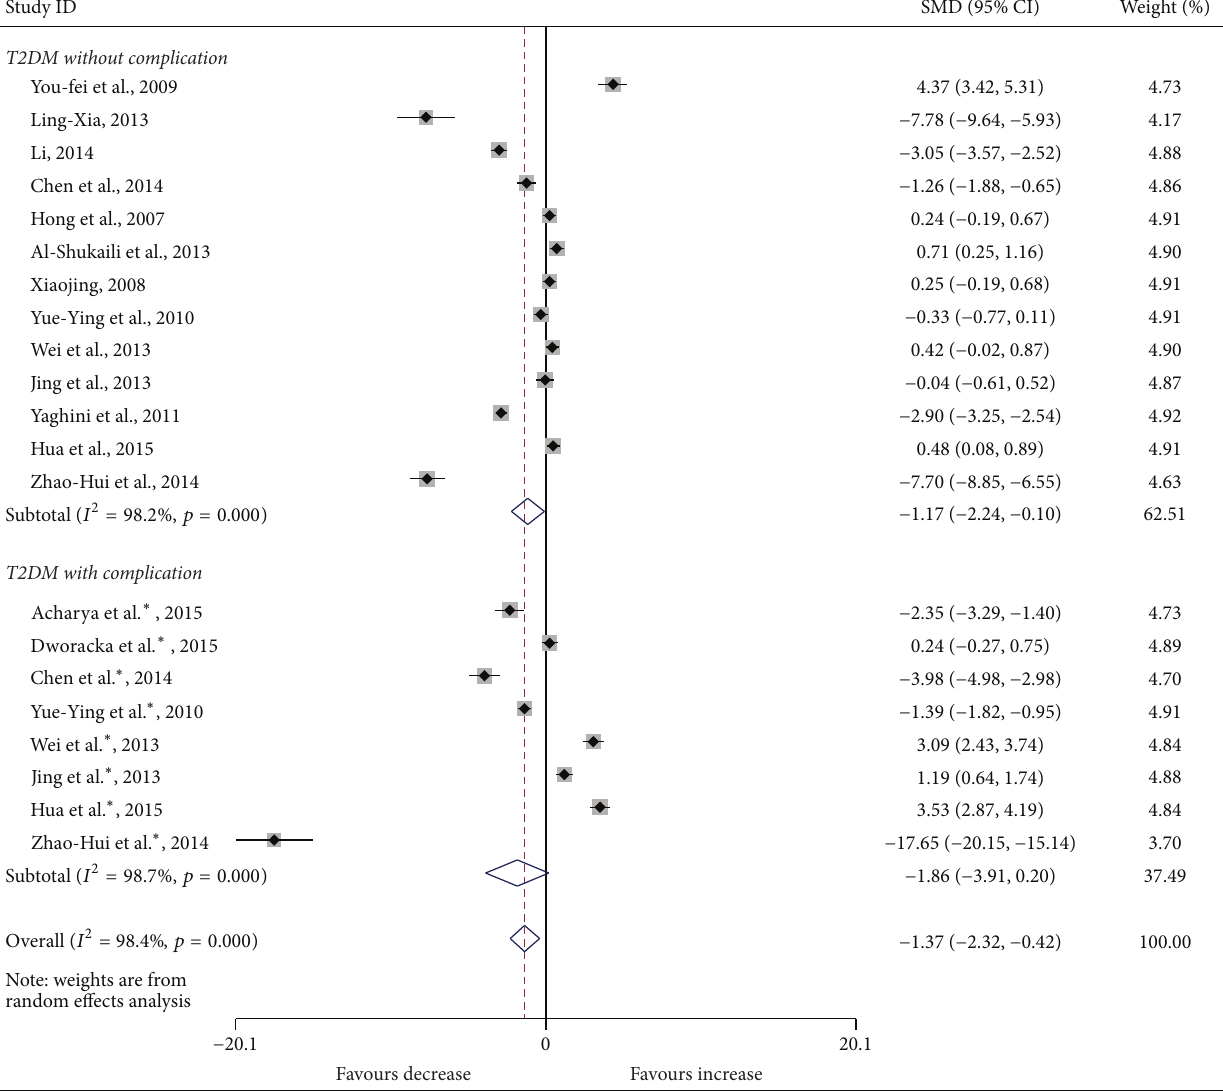
Figure 6: Forest plots for serum IL-10 in T2DM patients and controls with random effects model (T2DM without complication, 𝑝 = 0.033 ; T2DM with complication, 𝑝 = 0.076 ; overall, 𝑝 = 0.005 ). ∗ T 2 DM with